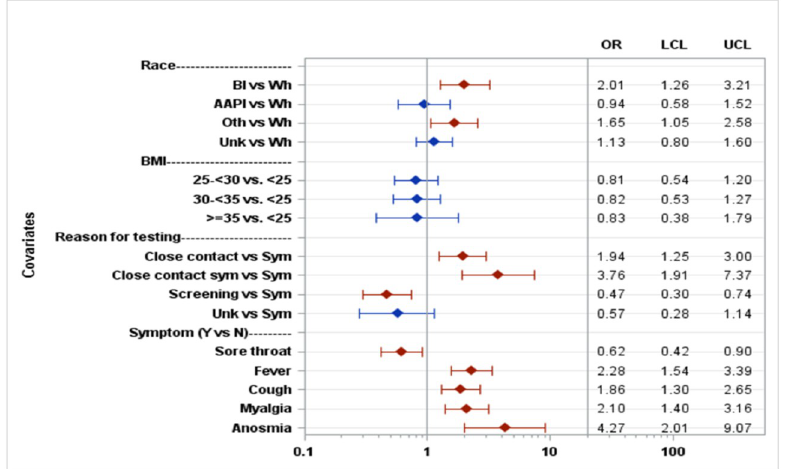
Fig 4. Adjusted ORs for positivity based on case-control